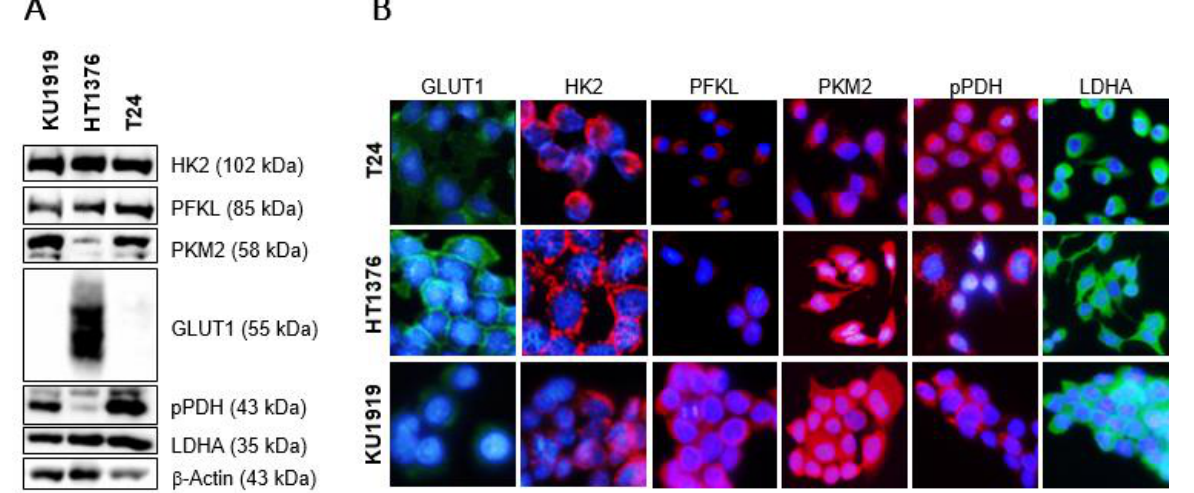
Figure 4. Western blot ( A ) and immunofluorescence ( B ) of baseline levels of GLUT1, HK2, PFKL, PKM2, pPDH, and LDHA in T24, HT1376, and KU1919 urothelial bladder carcinoma cell lines. Western blot ( A ) is representative of similar blots from three independent cell lysates. β -actin was used as a loading control. The uncropped blot is shown in Figure S1. Immunofluorescence images ( B ) were obtained at 400x amplification in an Olympus ® BX61 fluorescence microscope; cell nuclei were counterstained with DAPI.